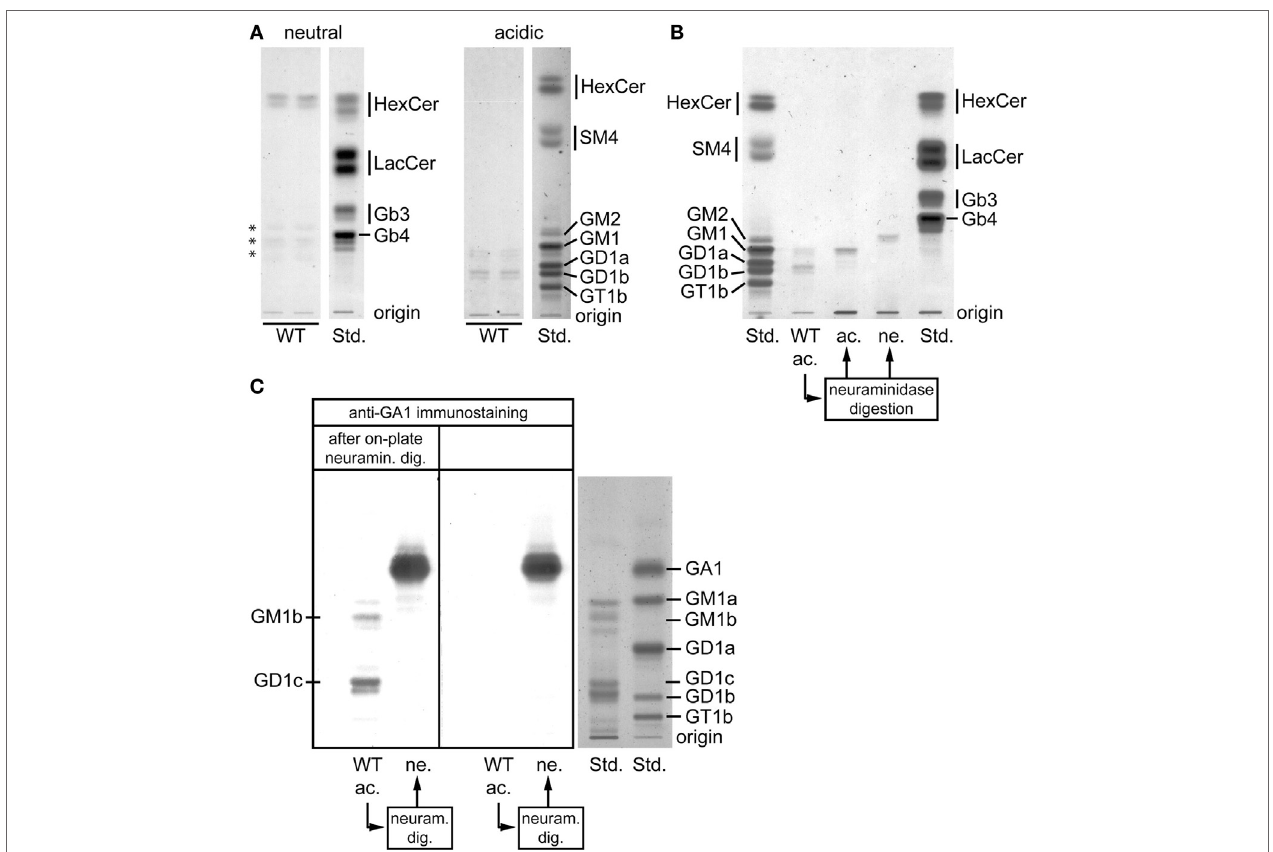
FigUre 2 | Glycosphingolipid (GSL) composition of double-positive (DP) thymocytes. (a) Neutral and acidic GSL were extracted from enriched wild-type (WT) DP thymocytes and analyzed by thin layer chromatography (TLC). Some GSL are represented by multiple bands due to their heterogeneous composition of ceramide moieties resulting in different running properties. The substances in the neutral fraction marked by asterisks did not show the typical orcinol color for GSL and therefore very unlikely represent GSL compounds. The displayed lanes represent parts of the chromatograms that are shown and further analyzed in Figure 3a . Orcinol staining. (B) The acidic GSL from WT DP thymocytes were digested by neuraminidase, separated into an acidic (ac.) and a neutral (ne.) fraction and ran in parallel with the original acidic fraction from WT DP thymocytes (WT ac.). The acidic compound obtained after the neuraminidase digestion ran at the height of the GM1 standard. By contrast, the neutral compound was not represented in the standards; however due to its running properties, it corresponded likely to neutral ganglioside GA1. Orcinol staining. (c) To verify from which acidic GSL of WT DP thymocytes its neutral backbone GA1 was released, an immunostaining with anti-GA1 antibodies was performed after additional “on-plate” neuraminidase digestion (left panel). Both the upper and the lower band contained GA1-based compounds. In view of this fact and the running properties, these bands likely correspond to GM1a, GM1b, GD1b, and GD1c. The part of the TLC plate containing GSL standards (Std.) was stained by